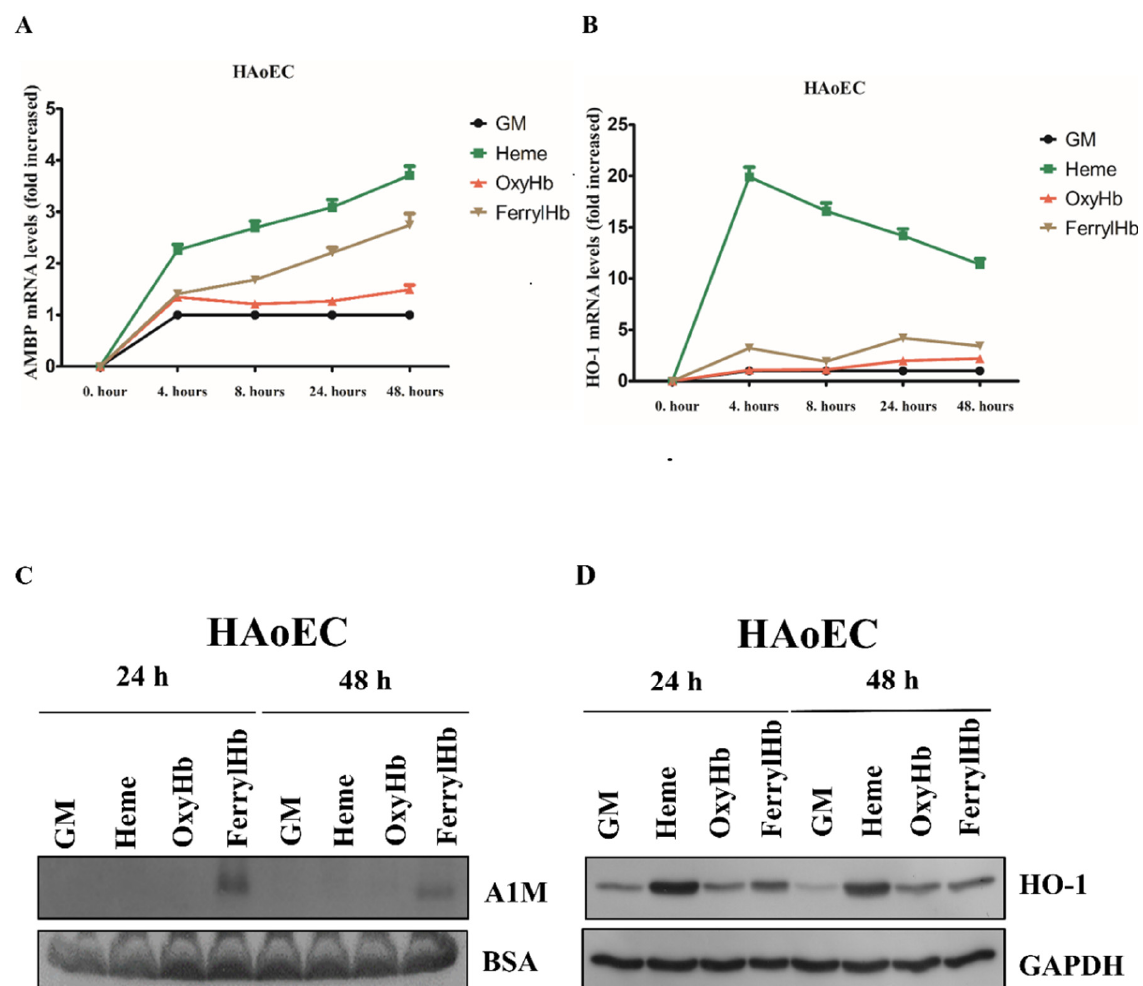
Figure 2. A1M expression is induced in human aortic endothelial cells (HAoECs). HAoECs were exposed to heme (10 µ M), OxyHb (10 µ M), or FerrylHb (10 µ M) in the presence of 5% foetal calf serum. A1M ( A ) and HO-1 ( B ) mRNA expression was quantified by qPCR after 4, 8, 24 and 48 h. ( C ) Secreted A1M protein was detected by immunoblotting in cell culture supernatants, while HO-1 protein level ( D ) was examined in cell lysates after 24 and 48 h. GM: growth medium, BSA: bovine serum albumin, GAPDH: glyceraldehyde 3-phosphate dehydrogenase.